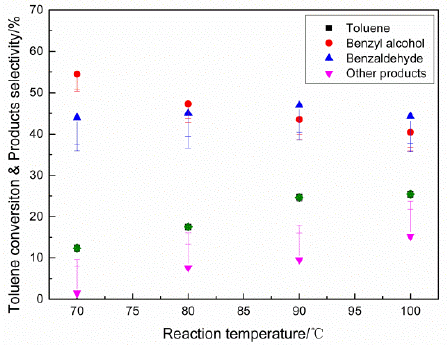
Figure 5. Catalytic performance for the selective oxidation of toluene on the Mn 3 O 4 / CNTs-3 at different temperatures.